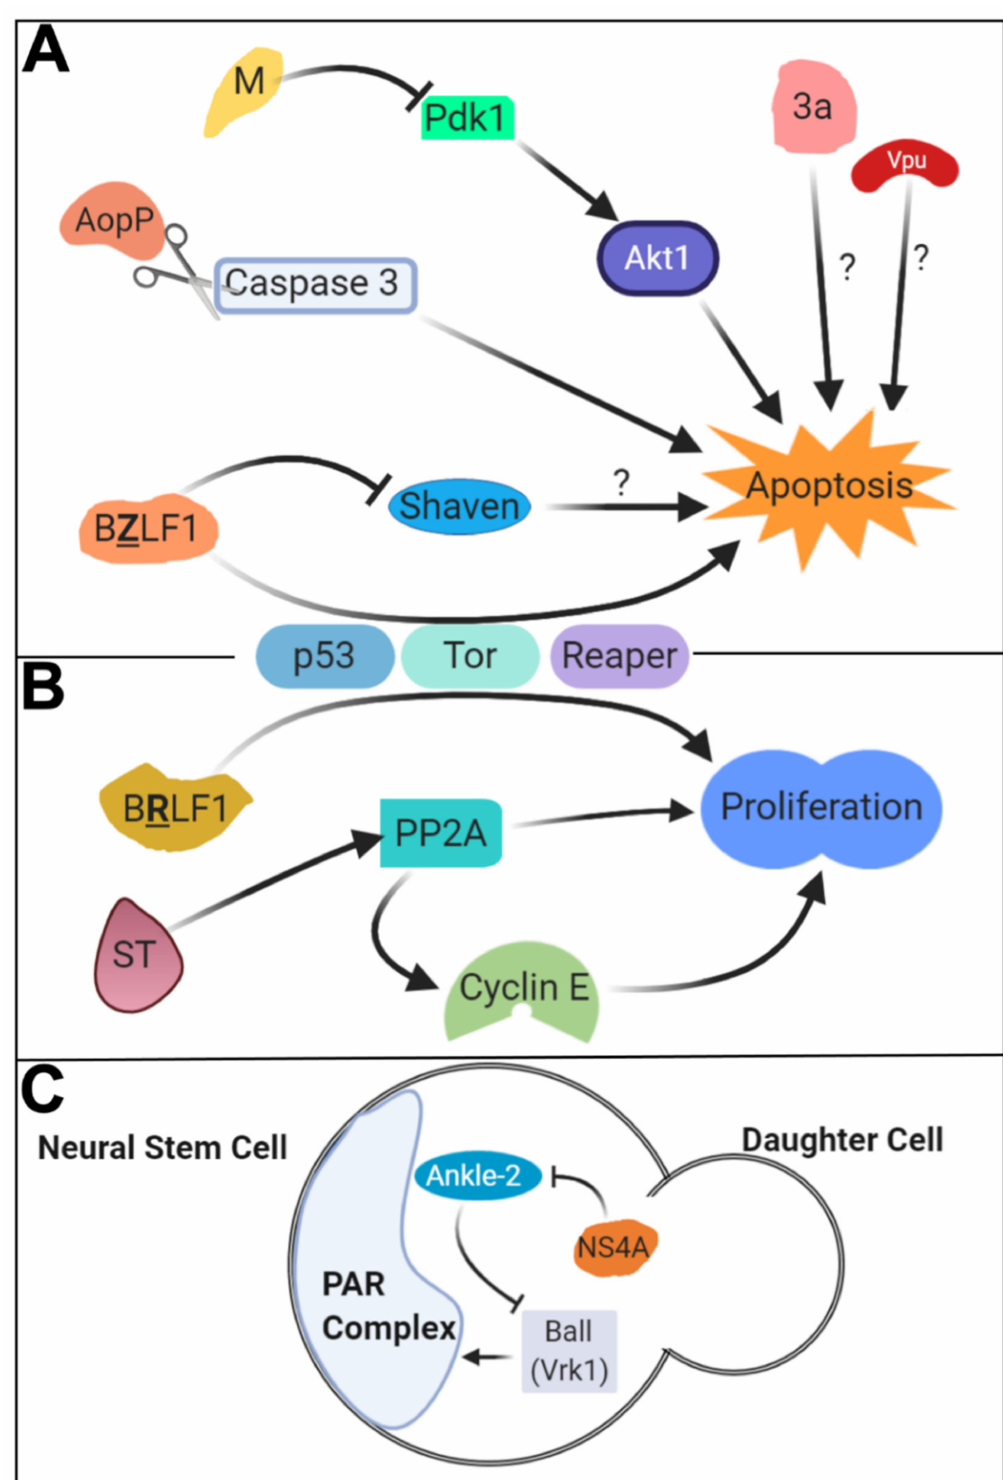
Figure 3. Virulence factors that affect apoptosis, cell proliferation, or asymmetric cell division studied in Drosophila . ( A ) Pathogenic proteins and their targets that affect apoptosis. Bacterial and viral proteins that induce apoptosis through activation of stress signaling pathways are not depicted here (see Figure 2 for these) ( B ) Pathogenic proteins and their targets that affect cell proliferation. ( C ) Pathogenic proteins and their targets that affect asymmetric cell division. Host proteins shown in cool colors and pathogenic proteins (3a (SARS-CoV-1), AopP ( A. salmonicida ), BRLF1 (EBV), BZLF1 (EBV), M (SARS-CoV-1), NS4A (ZIKV), ST (SV40), and Vpu (HIV)) are shown in warm